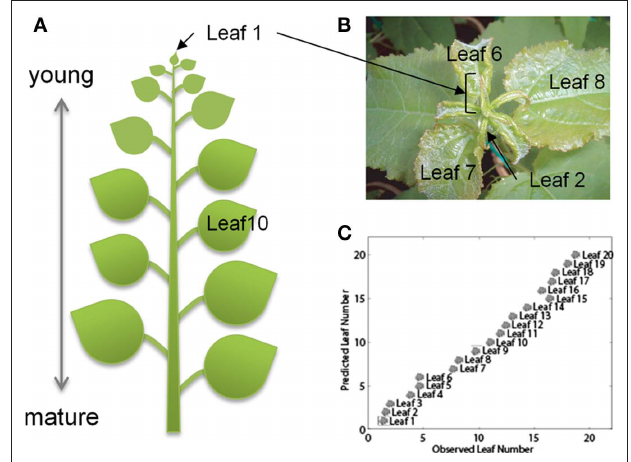
FiGure 1 | The OPLS model of the metabolite profile of Populus leaves at different sampling positions. (A) The leaf numbers (leaf) refers to the sampling position, where leaf one is the first leaf longer than 1 cm. We sampled leaves from position 1 (leaf 1) to position 20 (leaf 20). (B) Expansion of upper side including apex, leaf 1 to leaf 8 of an aspen plant. (C) The number of components in the OPLS model was determined as two (one orthogonal and one predictive) according to seven-fold full cross-validation (Wold, 1978). The model explains 98.1% of the variation in Y ( R 2 Y = 0.981) and the estimated ability to predict 92.1% of the variation in Y ( Q 2 Y = 0.921) according to cross-validation. The model was able to model 47.8% of the variation in X , 22.9% of the variation is correlated to leaf position ( Y ) and 24.9%